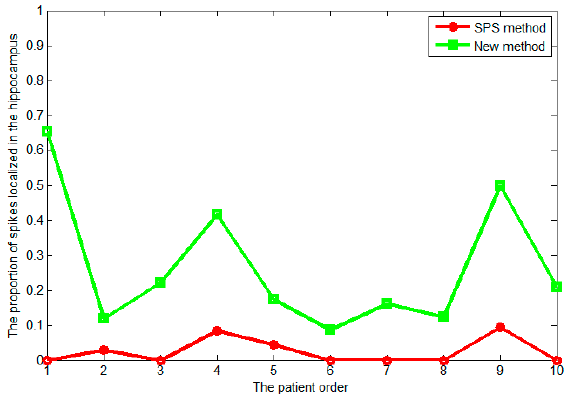
M indicates male; F, female; Pa, parietal; In, insular; LT, left temporal; RT, right temporal; LHS, left hippocampal sclerosis; RHS, right hippocampal sclerosis; HRH, hyper T2 in right hippocampal; BHS, bilateral hippocampal sclerosis; LATH, left anterior temporal lobectomy including hippocampus; RATH, right anterior temporal lobectomy including hippocampus; Am, amygdala; FCD, focal cortical dysplasia.